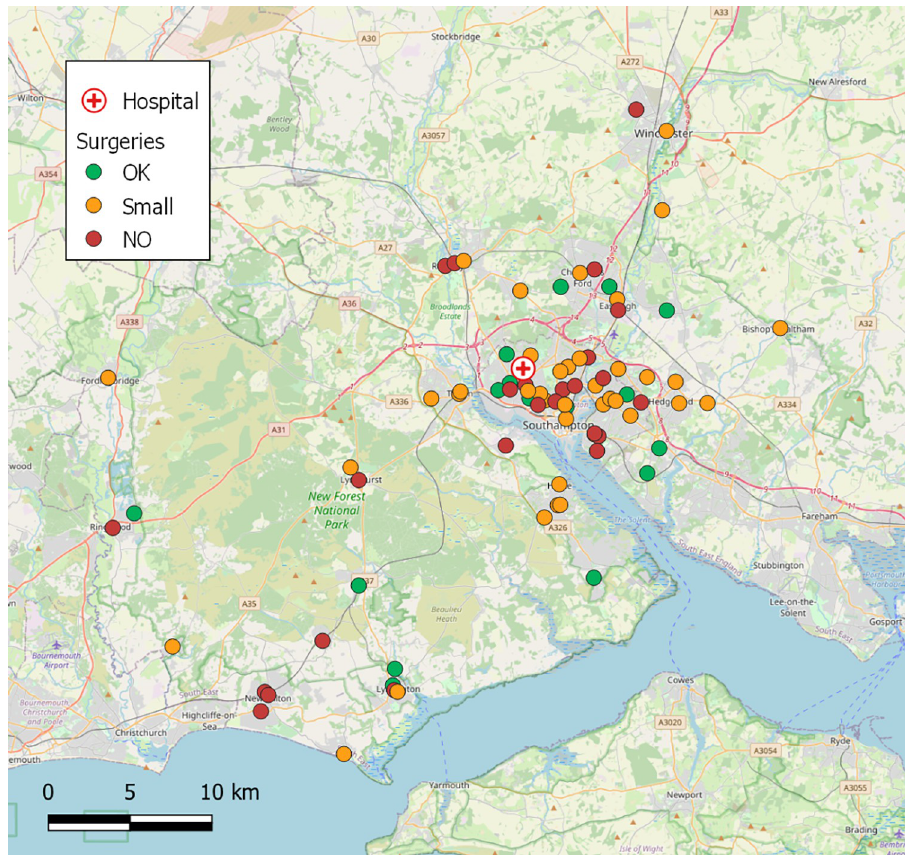
Fig 5. Locations of GP Surgeries in the Southampton area, coloured by landing site suitability. OK = suitable for a 5m fixed-wingspan craft to land with a reasonable safety buffer and existing facilities not significantly impacted (e.g., qty. of car park spaces taken). Small = suitable for 2m VTOL UAV. No = not suitable for a UAV of any size. Only landing site considered, risk of flight to site not considered. Private land not considered due to long term feasibility. Base map and data from OpenStreetMap and OpenStreetMap